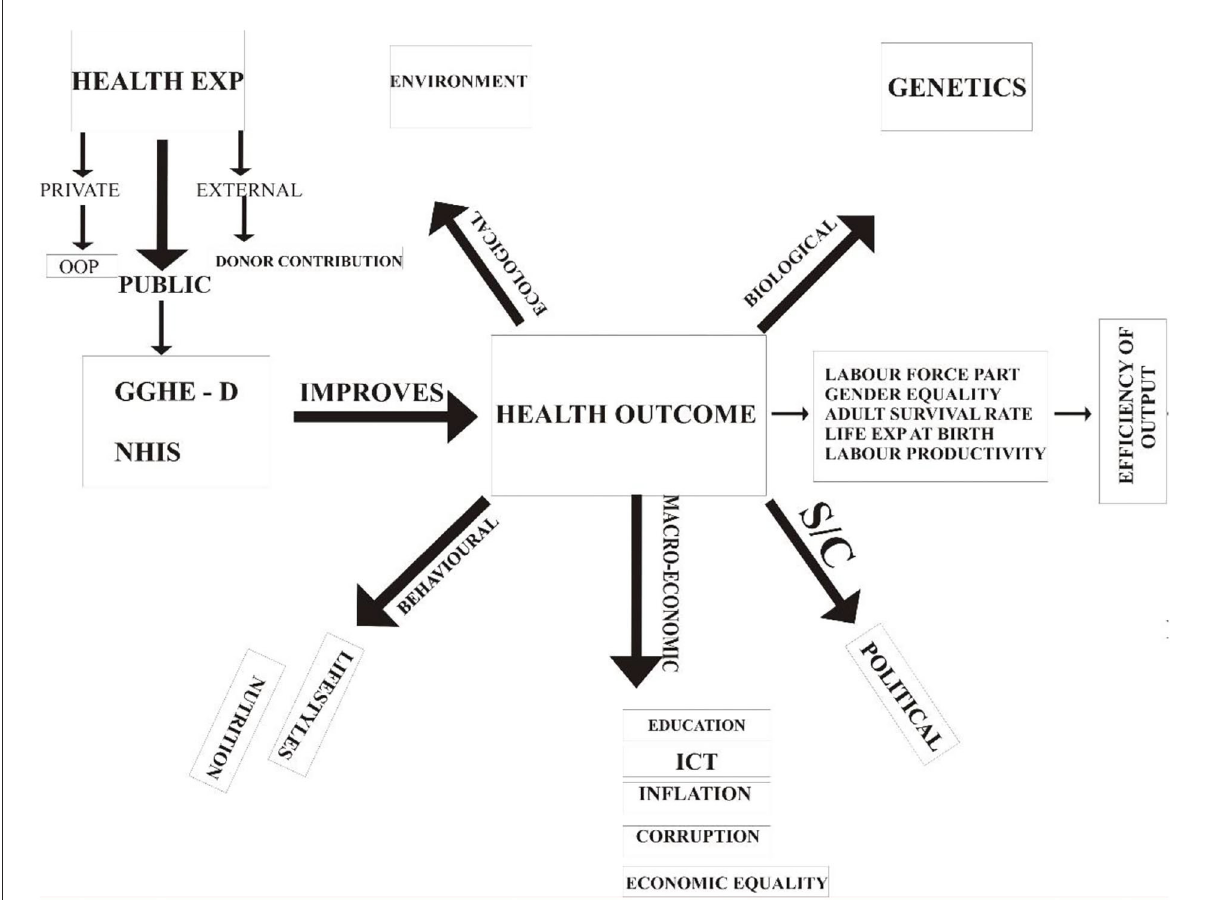
FIGURE1 A conceptual framework connecting the effects of health expenditure and other determinants of health outcomes. Source: Authors’